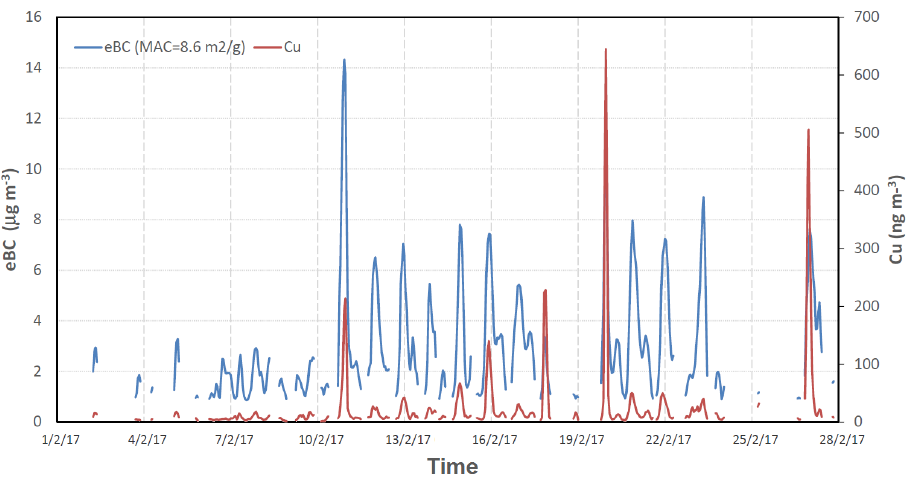
Figure 6. Hourly data Cu concentrations obtained by Particle Induced X-ray Emission (PIXE) analysis) and eBC values retrieved from absorption coefficients measurement by polar photometry using the site-specific Mass Absorption Coefficient (MAC) value estimated for this